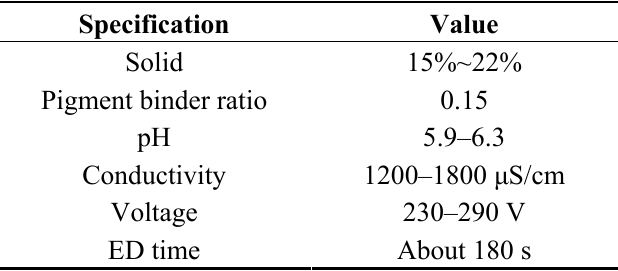
Table A1. Condition of